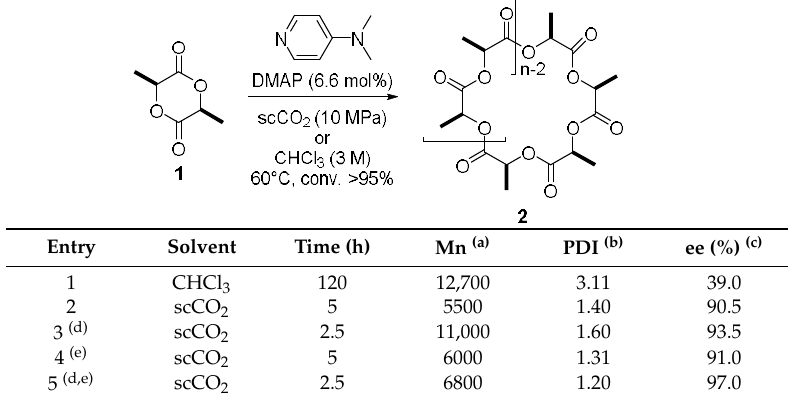
Table 1. Organocatalytic c PLA synthesis in supercritical carbon dioxide (scCO 2 ).